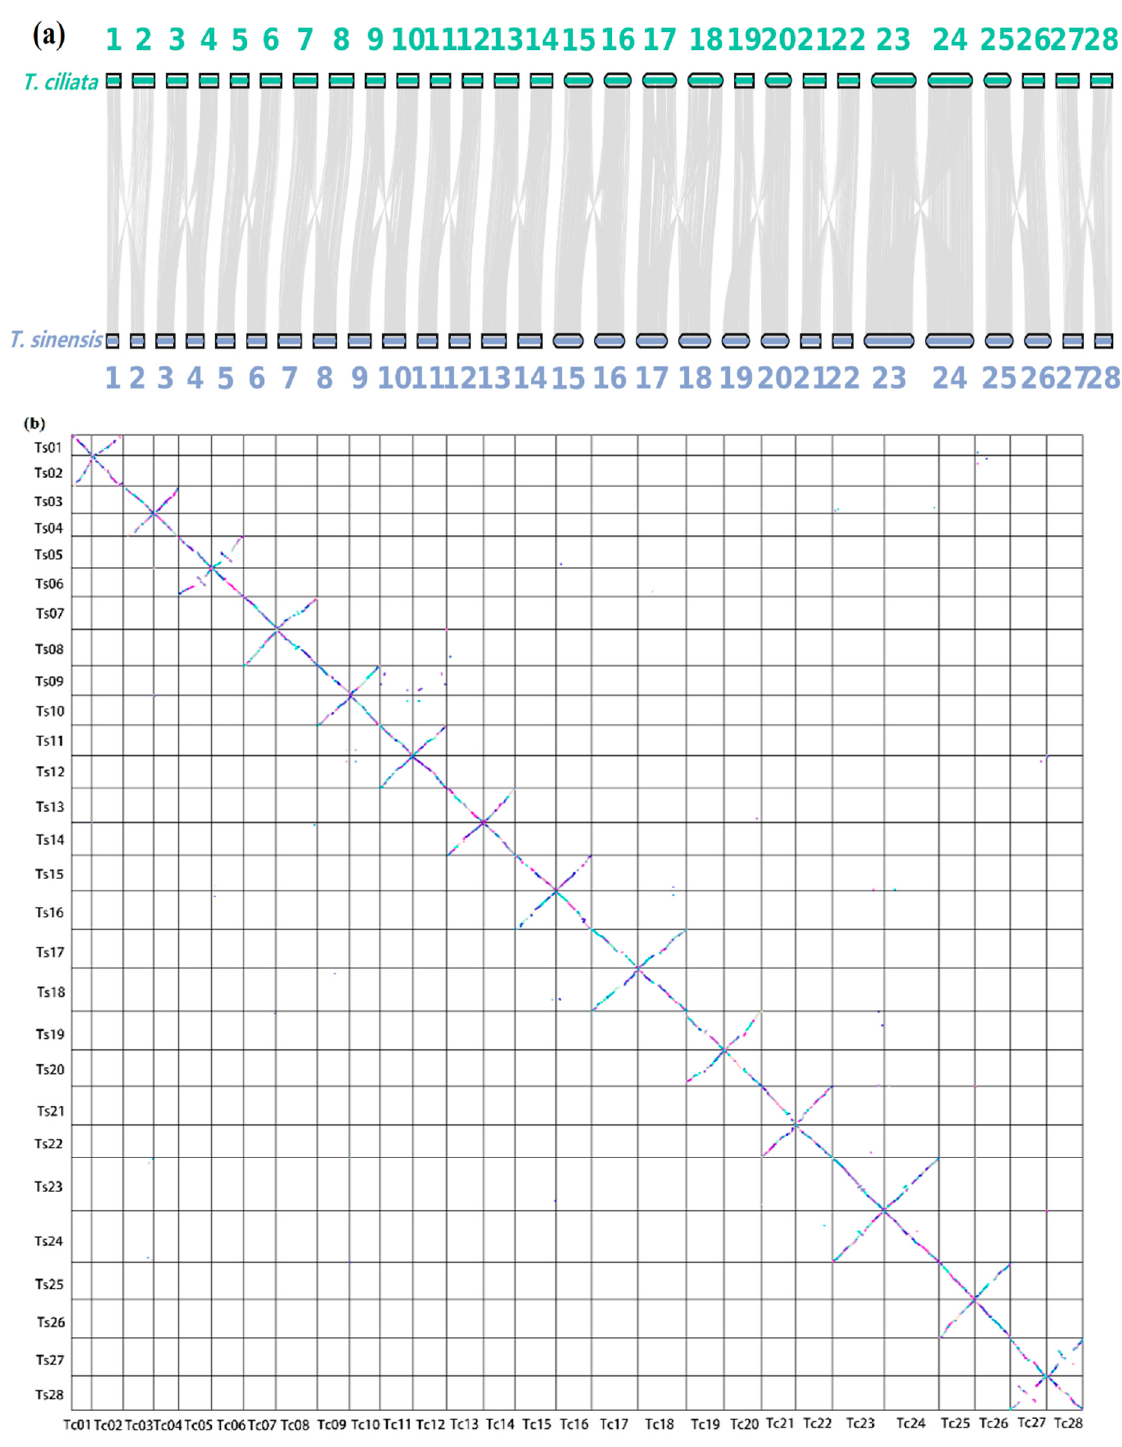
Figure 3. Collinearity map and dot plot of twenty-eight chromosomes shared by T. ciliata and T. sinensis : ( a ) Collinear map for each chromosome pair shared by the two species; ( b ) Dot plot of twenty-eight chromosomes shared by the two species. Symbols Tc01, Tc02, …, and Tc28 represent chromosomes 1,2, …, and 28 of T. ciliata genome, respectively. Symbols Ts01, Ts02, …, and Ts28 represent chromosomes 1, 2, …, and 28 of T. sinensis genome, respectively.